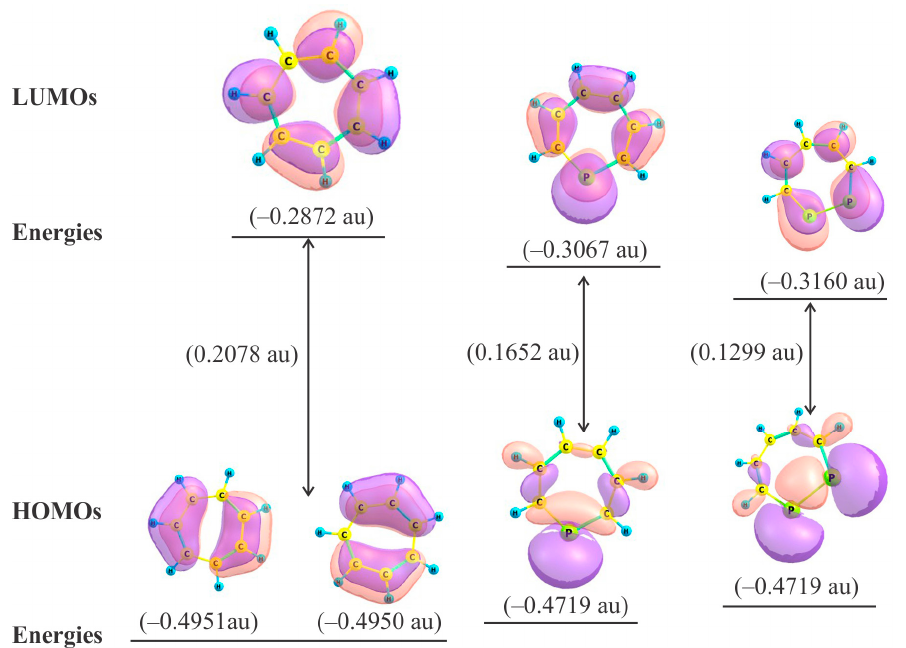
Figure 3. Frontier molecular orbitals (FMOs) of the tropylium cation ( 1 ); phosphatropylium cation ( 2 ) and 1,2-diphosphatropylium cation ( 3 ).